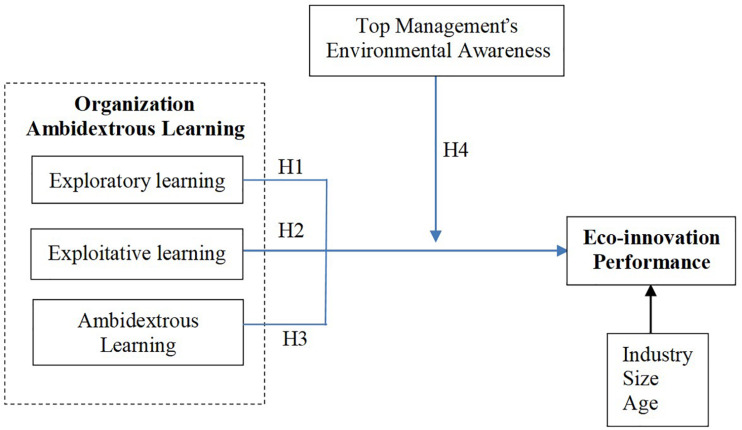
Research framework.